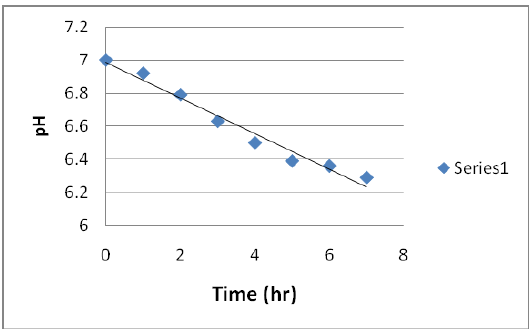
Figure 5. Change in pH at different time intervals during microbial growth.